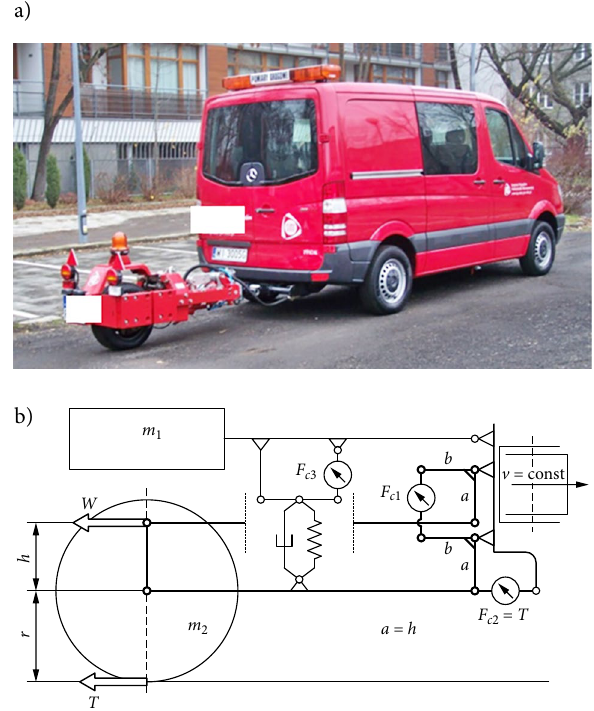
Figure 1. Fourth generation of skid resistance tester SRT-4: a – a photo of towing vehicle and dynamometer trailer; b – kinematic schema of dynamometer trailer with double